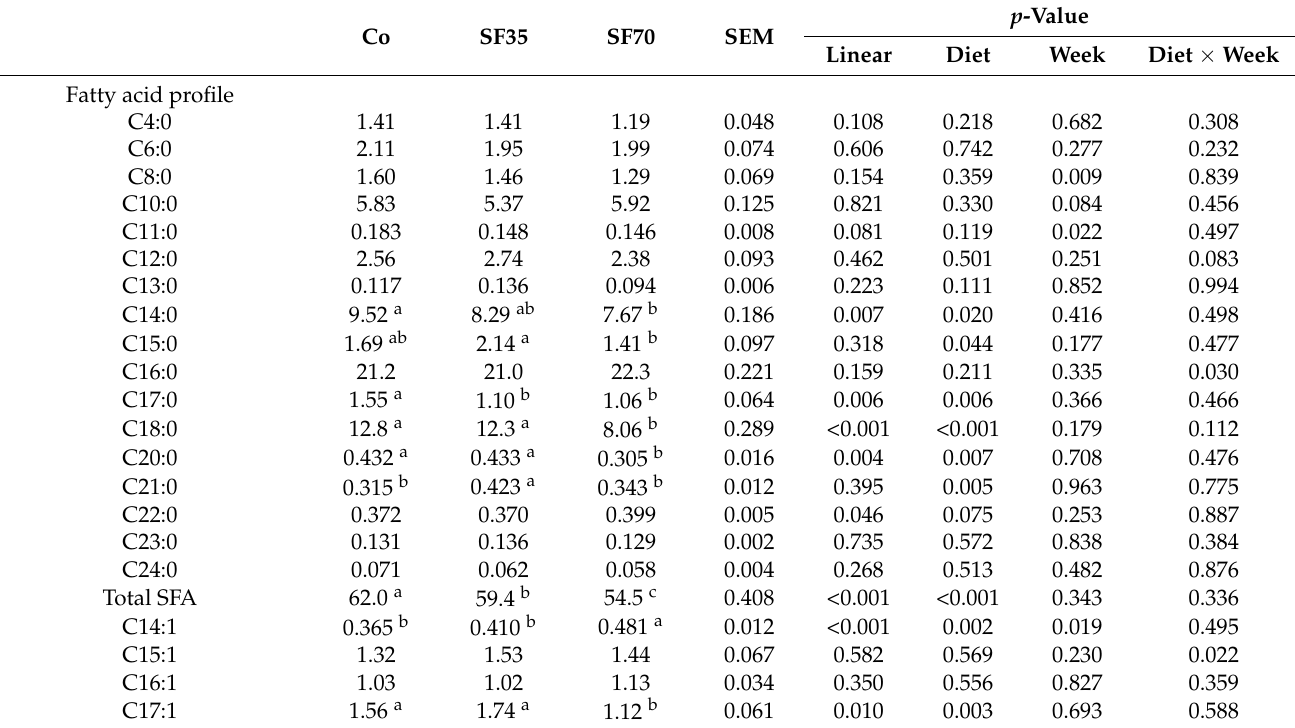
Table 5. Least square means and standard error of the mean of fatty acid profile (g/100 g FA)